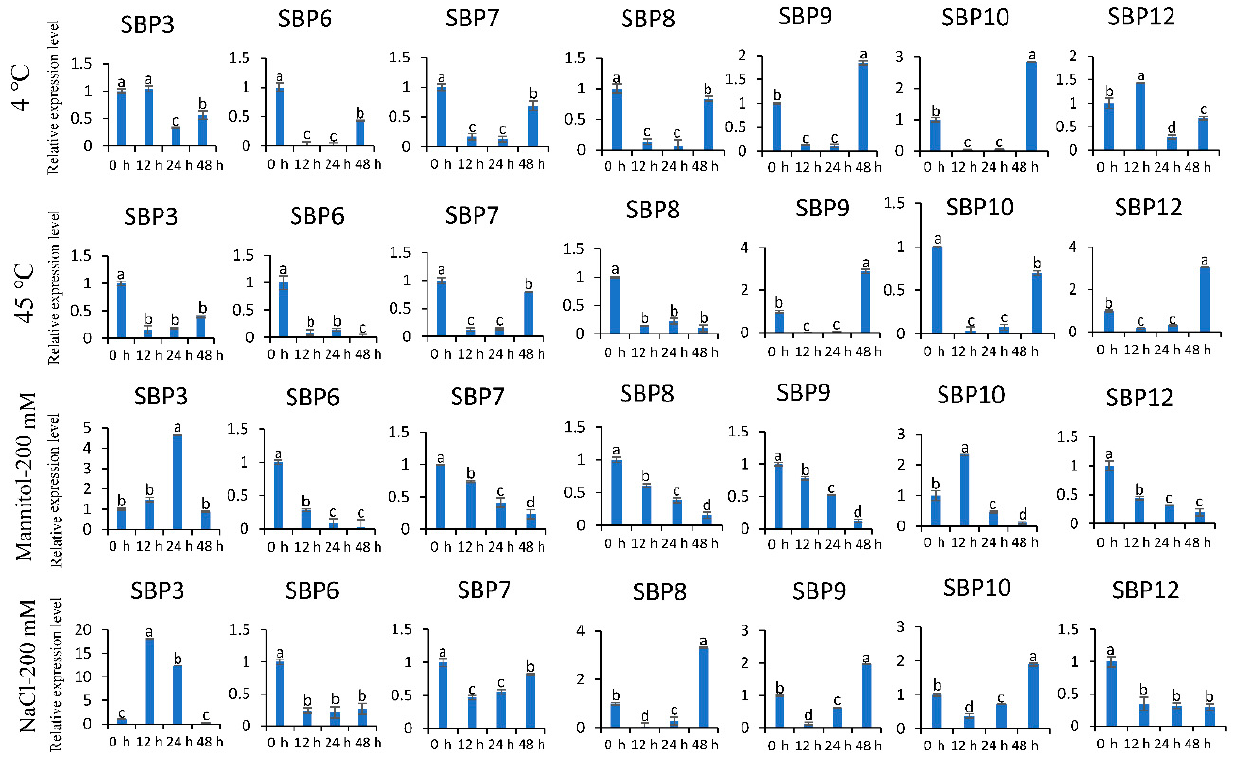
Figure 9. The relative expression levels of seven SBP genes in response to different stress treatments in passion fruit. Significant differences between samples labeled a, b, c, and d were determined by one-way ANOVA, p < 0.05.